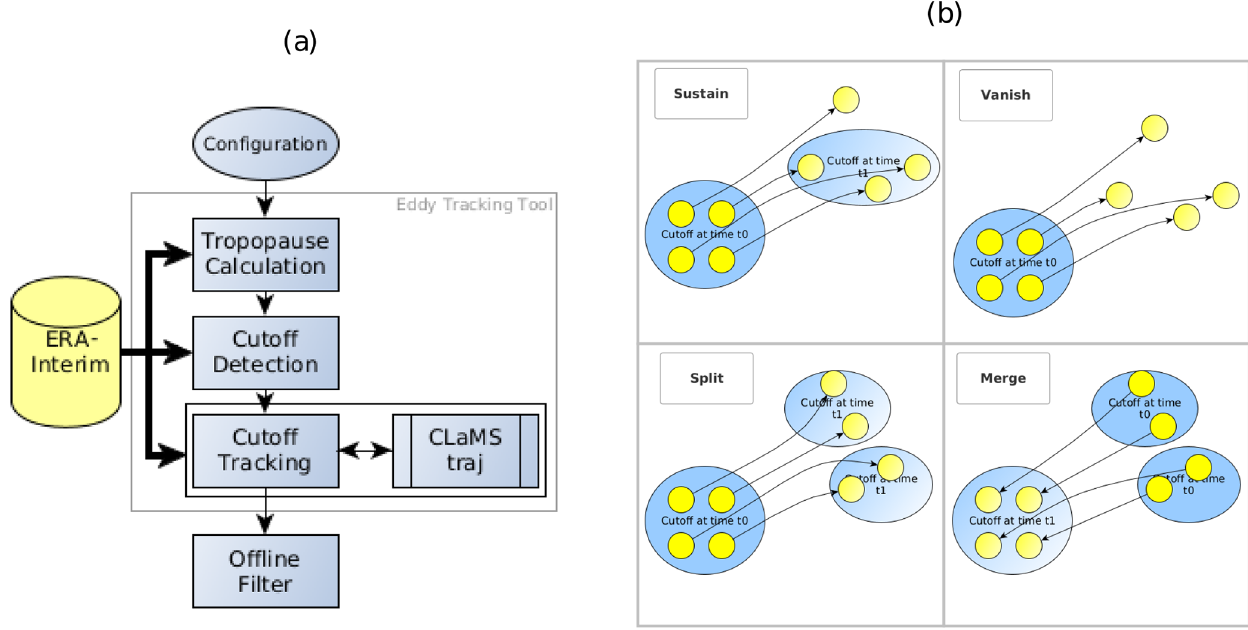
Figure A1. (a) Structure of the PV cutoff tracking tool and (b) a schematic of different evolutions of PV cutoffs. A cutoff can remain, vanish, split, or merge. The blue circles without and with a colour gradient illustrate cutoffs at times of t 0 and t 1 . Yellow circles show individual air